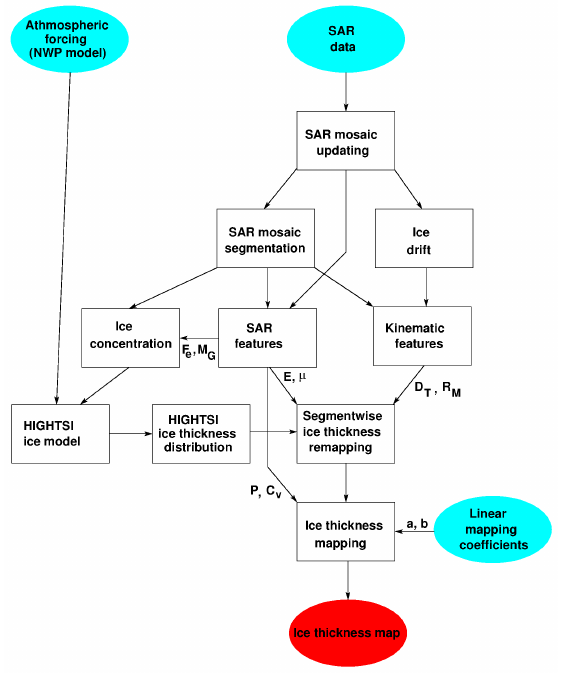
Fig. 9. A general block diagram of the ice thickness estimation scheme. The parameters delivered from one step to another are also shown (with the same names as in the equations).